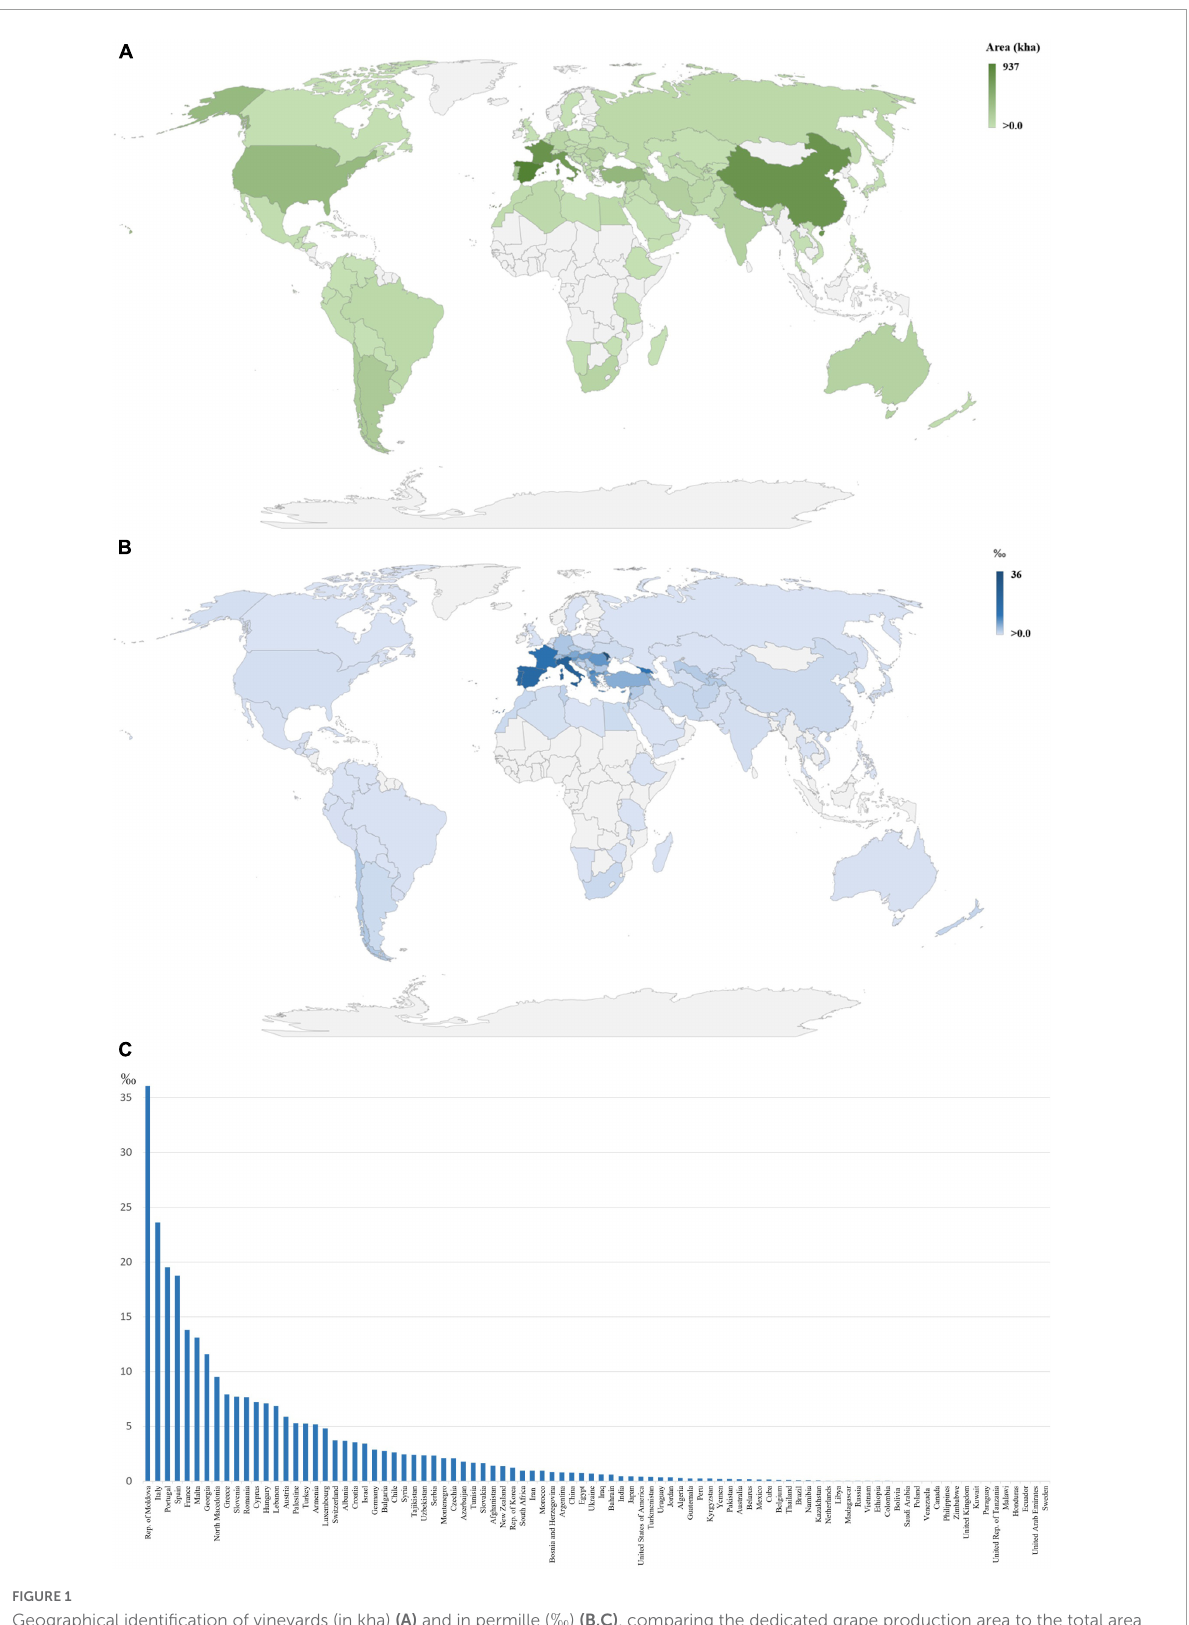
) (B,C) , comparing the dedicated grape production area to the total area (cid:104)